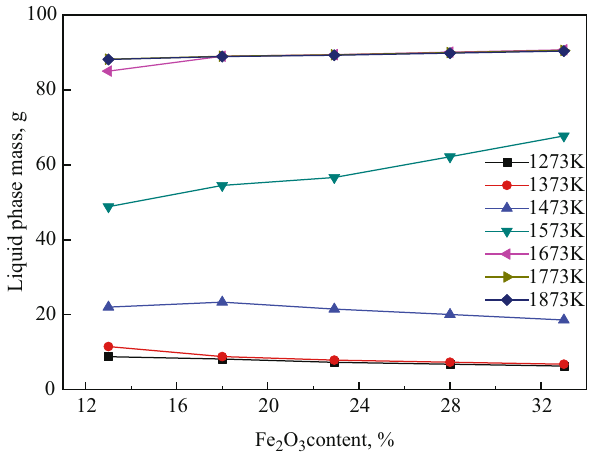
Figure 12: Relationship between liquid production and Fe 2 O 3 con - tent at di ff erent temperatures.